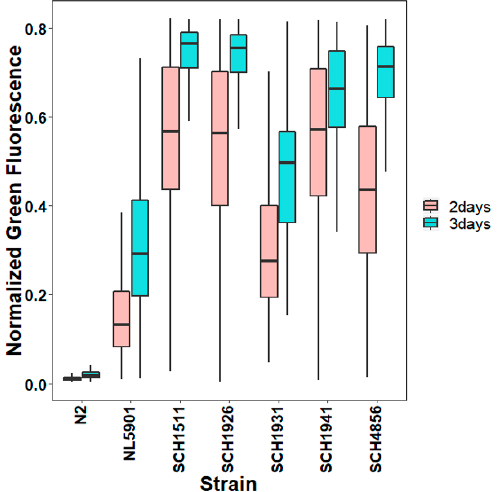
Figure 3. Quantifications of α -synuclein-YFP fusion protein by the COPAS Biosorter, with N2 as the negative control. The six transgenic strains contain α -synuclein but differed among the genetic backgrounds. The fluorescent signal levels were substantially different among 2-day-old worms (ANOVA, p << 10 − 5 , F value = 695.98 with df = 5), while similarity was among the 3-day-old transgenic worms (ANOVA, p << 10 − 5 , F value = 682.17 with df = 5). Post-hoc Tukey tests can be found in Table S4.